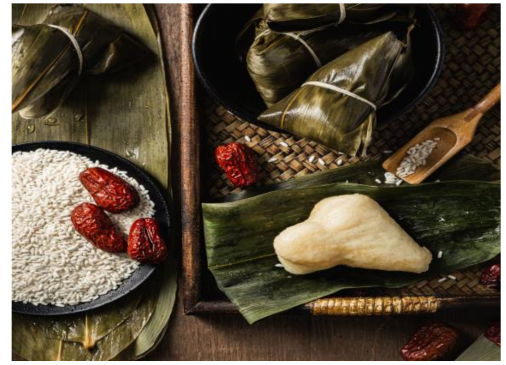
Figure 1. Zongzi. Source: Unplash. Zongzi [24].